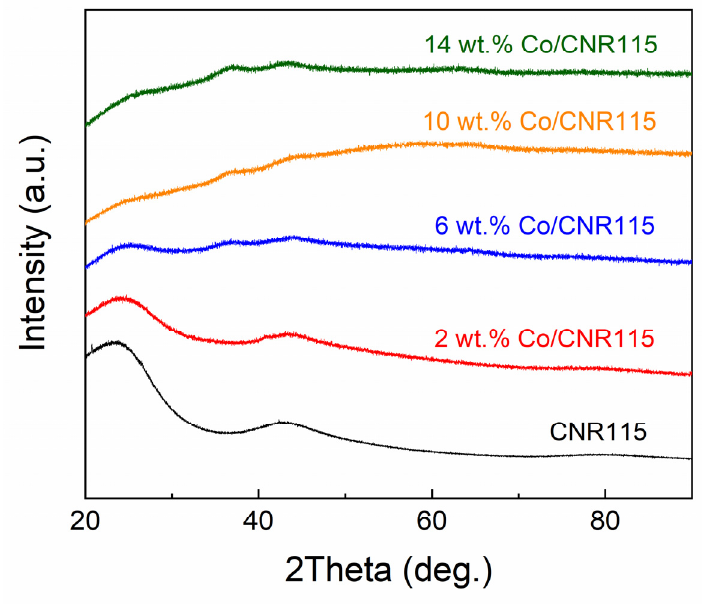
Figure 2. X-ray diffraction (XRD) pattern for CNR115 support and the four catalysts, 2, 6, 10 and 14 wt.% Co/CNR115, after reduction process.